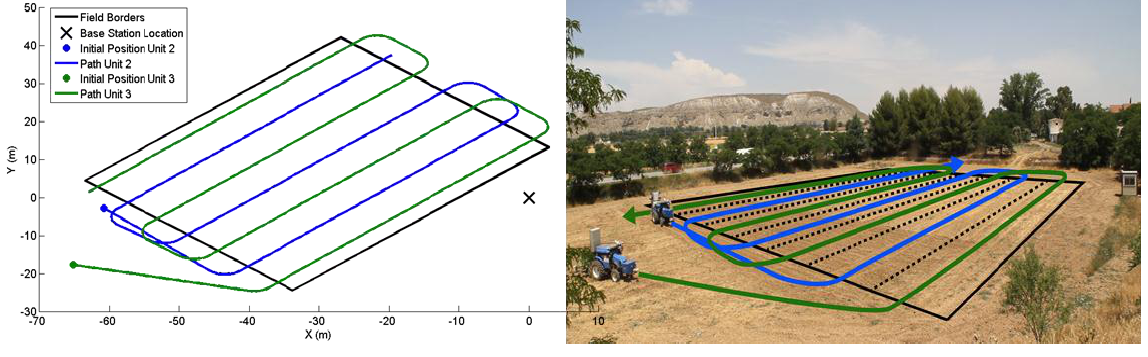
Figure 13. Trajectories for the two tractors in the second